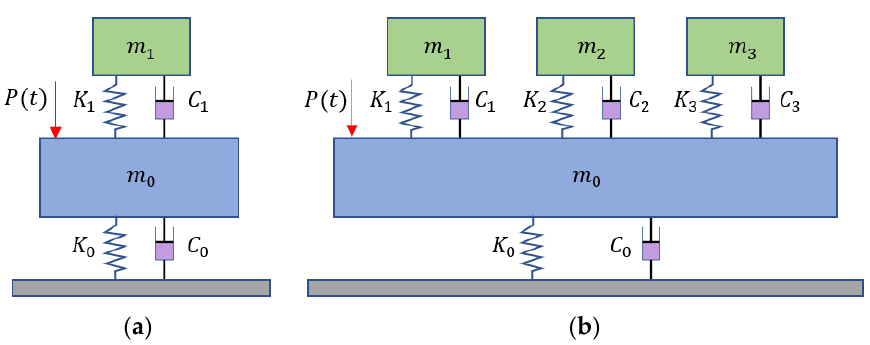
Figure 6. Comparison of the mechanical models of: ( a ) single tuned mass damper (STMD) and ( b ) multiple tuned mass dampers